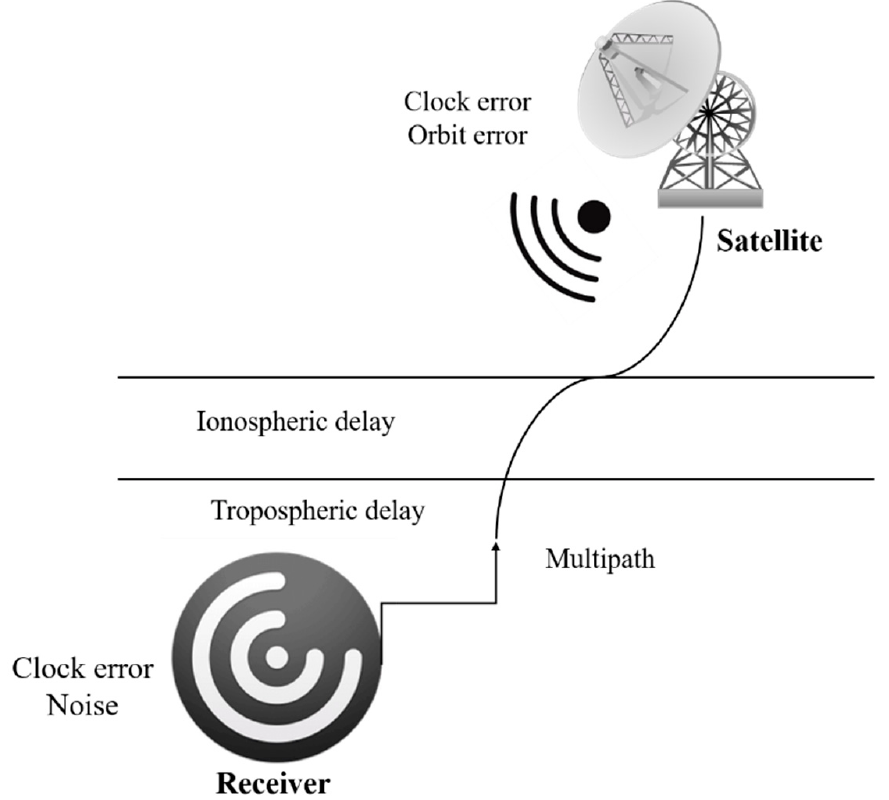
Figure 11. Principal Global Positioning System (GPS) errors.